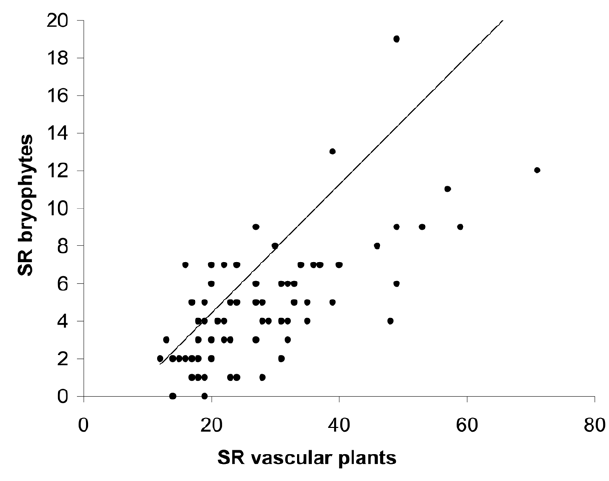
Figure 2. Relationship between species richness of bryophytes and vascular plants. Relationship between species richness of bryophytes and vascular plants ( n =85; y=0.17x - 0.15; R 2 =0.47; F=74.1; P , 0.0001).